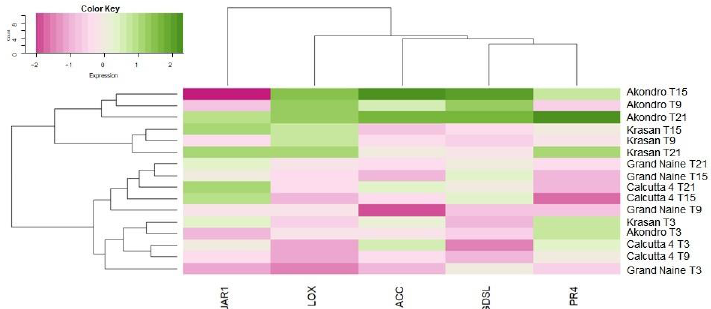
Figure 3. Hierarchical clustering of differentially expressed genes at four sampling times after inoculation with P. fijiensis in samples of Calcutta 4, Krasan Saichon, Grand Naine and Akondro Mainty. T3: 3 days after inoculation, T9: 9 days after inoculation, T15: 15 days after inoculation, T21: 21 days after inoculation. JAR1: jasmonate-amino acid conjugate enzyme; LOX: lipoxygenase; ACC: 1- amino-cyclopropane-1-carboxylate 1-carboxylic acid-1-aminocyclopropane; GDSL: lipase/hydrolase; PR4: pathogenesis-related protein. Quantifications were normalized using the 25S and tubulin Musa sp., reference genes.